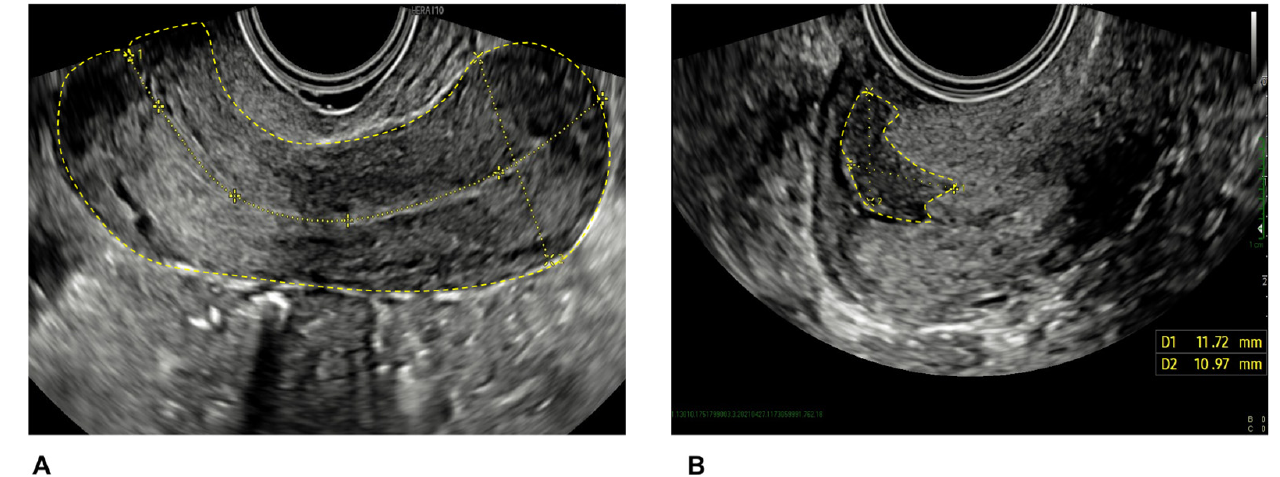
Figure 1. Ultrasound scan image showing the uterus ( A ) and tumor ( B ) diameters in two dimensions. The tumors were assessed with color or power Doppler ultrasound. The intra-tumoral blood flow was classified subjectively as no detectable blood flow (color score = 1), minimal blood flow (color score = 2), moderate blood flow (color score = 3), or abundant blood flow (color score = 4) depending on the amount of color Doppler signals detected in the tumor